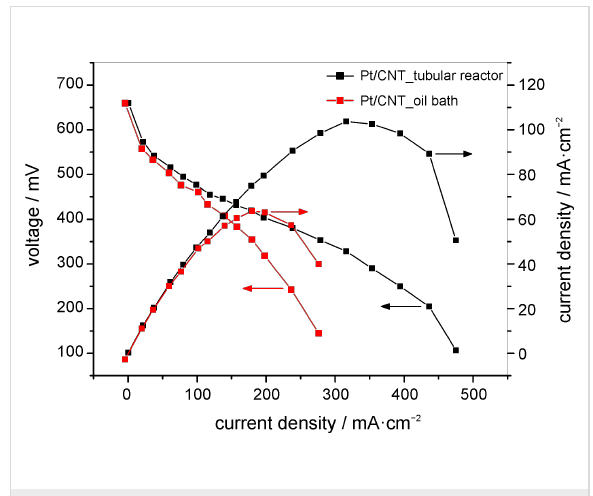
Figure 6: Comparison of performance in DMFC with Pt/CNT oil bath and Pt/CNT tubular reactor samples as cathode catalysts (Pt loading of 1 mg·cm − 2 on each anode and